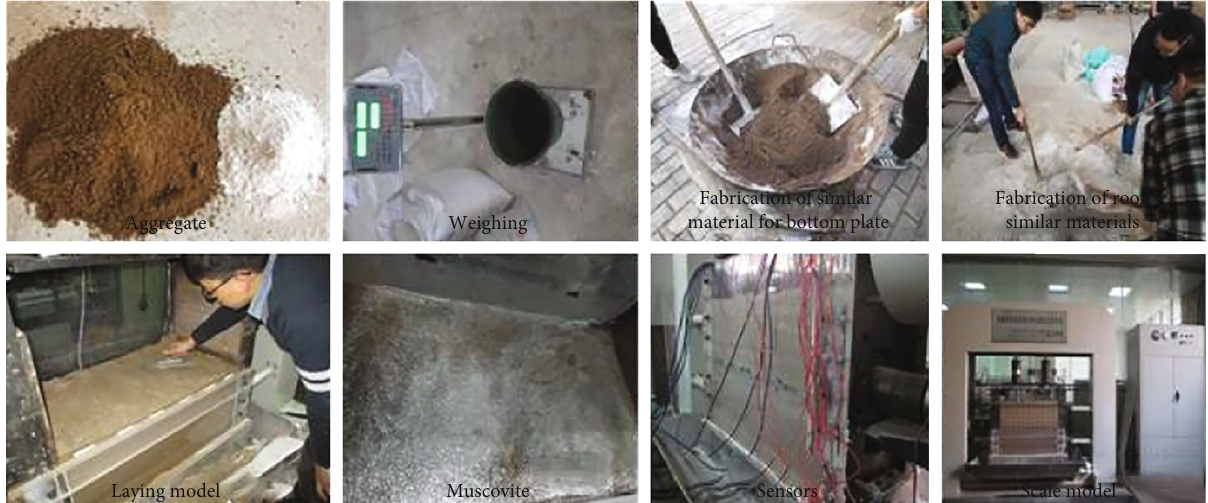
Figure 7: The construction process of the physical model.